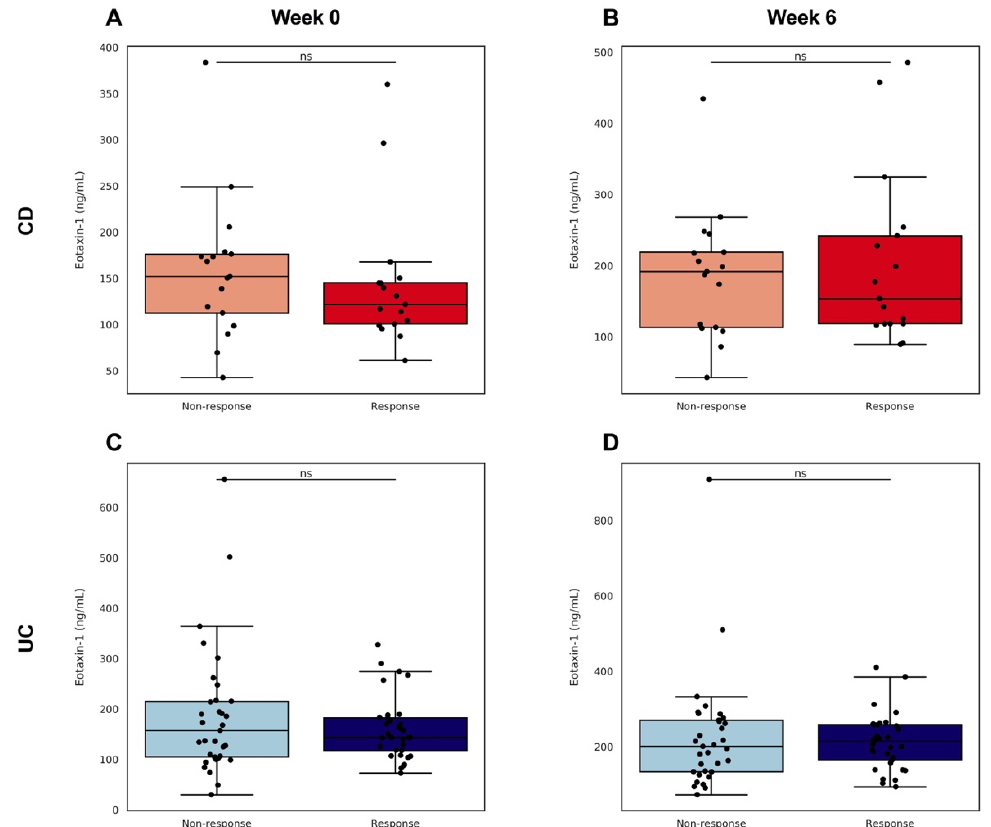
Figure 4. ( A – D ) Serum eotaxin-1 levels at week 0 and week 6in responders and non-responders to vedolizumab induction therapy in patients from the GEMINI cohort. ( A , B ) Patients with CD showed no differences in serum eotaxin-1 levels at baseline nor after six weeks of therapy. ( C , D ) Similarly, patients with UC demonstrated no significant differences at baseline or at week 6 of ther- apy.